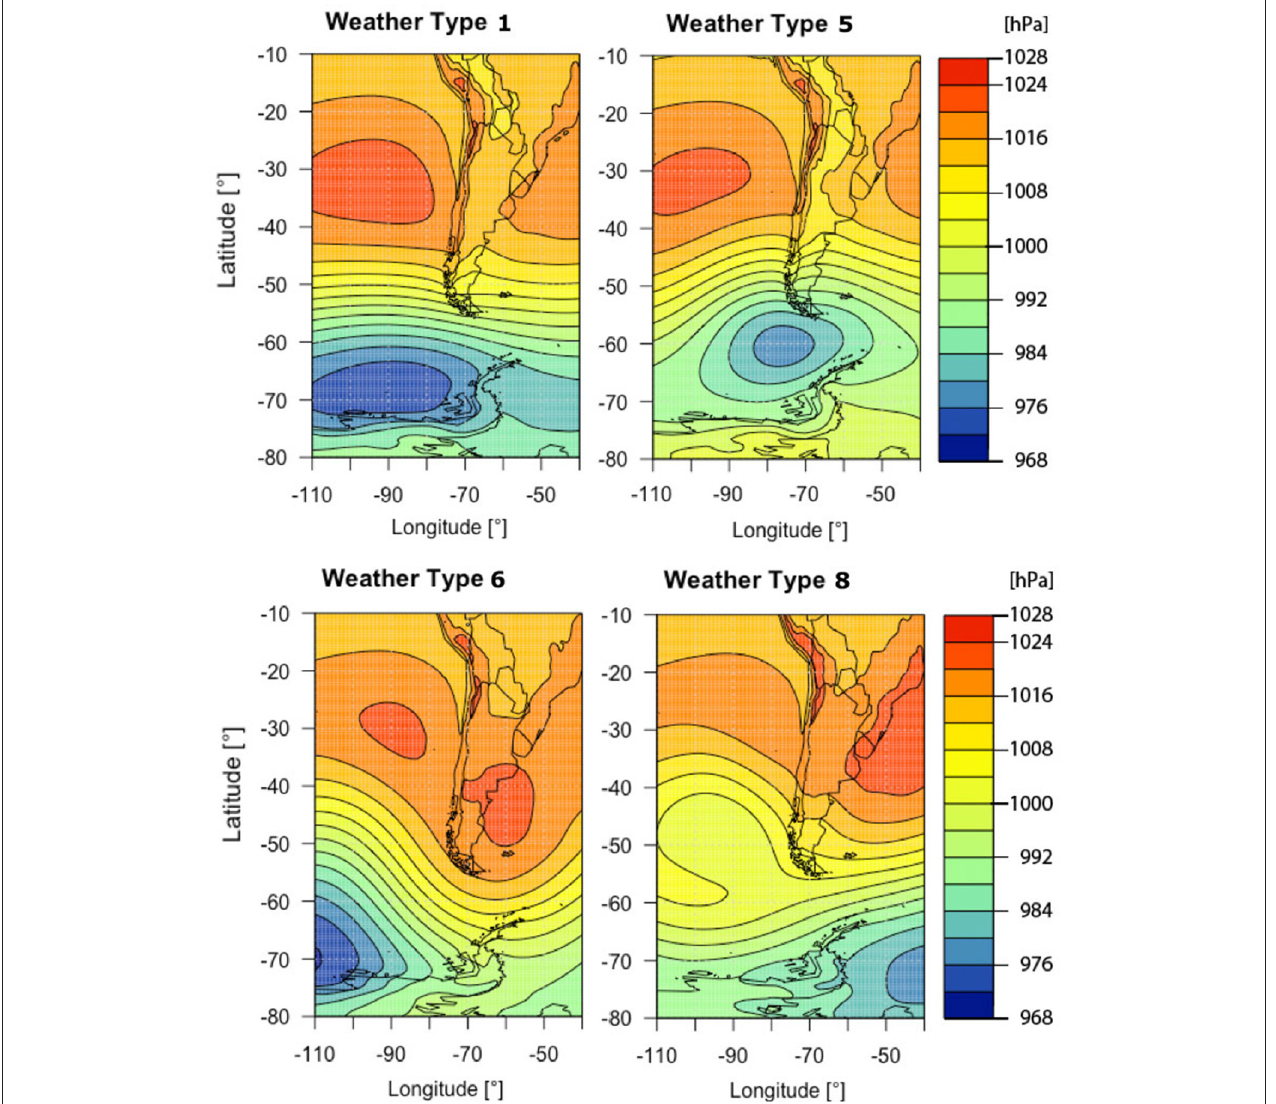
FIGURE 9 | Most relevant main weather types (GWL’s) for this study as defined by Weidemann et al. (under review) for South America.